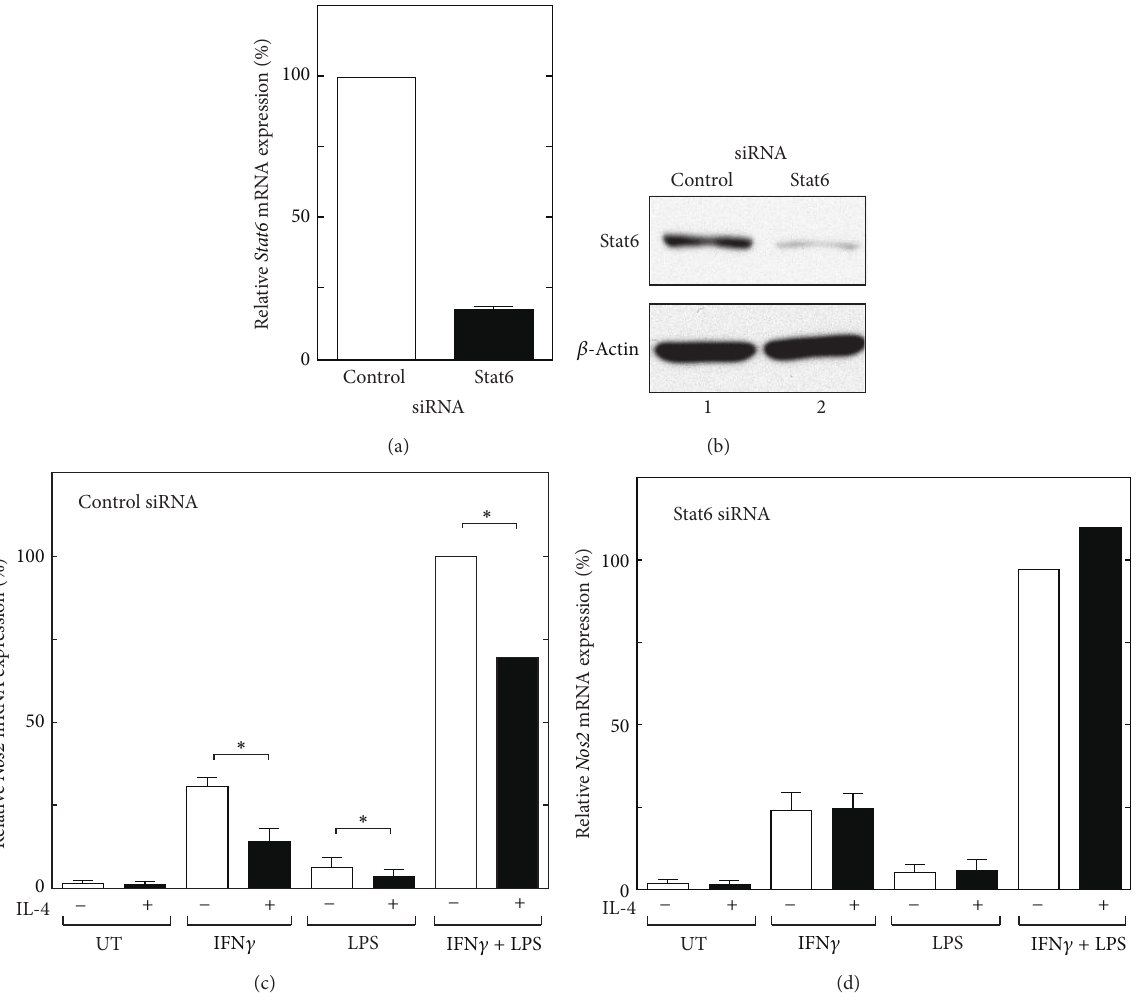
Figure 2: Stat6 is required for the IL-4-mediated inhibition of Nos2 gene expression in RAW264.7 cells. (a) RAW264.7 cells were transfected with control siRNA (100nM) or Stat6 siRNA (100nM) for 36 hours; total RNA was then prepared for quantitative real-time RT-PCR. Each column and bar represents the mean ± SEM of three independent experiments. (b) RAW264.7 cells were transfected with siRNA, as described above, and then used to prepare total cellular lysates for a western blot analysis using an anti-Stat6 antibody. (c, d) RAW264.7 cells were transfected with control siRNA (100nM) or Stat6 siRNA (100nM). Thirty-six hours after transfection, the cells were either left untreated (UT) or treated with IL-4 (10ng/mL) for 30 min prior to stimulation with IFN 𝛾 (10ng/mL) and/or LPS (100ng/mL) for 8 hours before the preparation of total RNA for quantitative real-time RT-PCR. The relative Nos2 mRNA expression levels are shown as percentages of the activity of cells transfected with the control siRNA and stimulated with IFN 𝛾 and LPS. Each column and bar represents the mean ± SEM of three independent experiments. The asterisks denote a statistically significant difference compared to the cultures treated with IL-4 ( 𝑃 < 0.05 , Student’s 𝑡